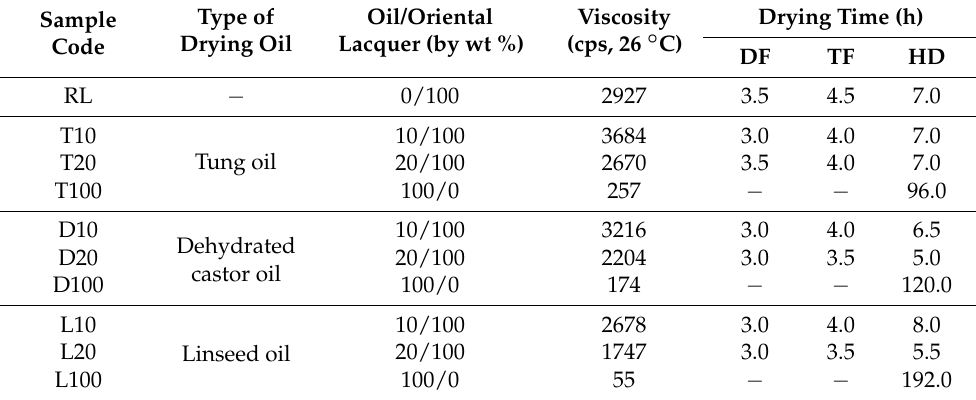
Table 1. Viscosity and drying time of refined lacquer with different types of drying oil and